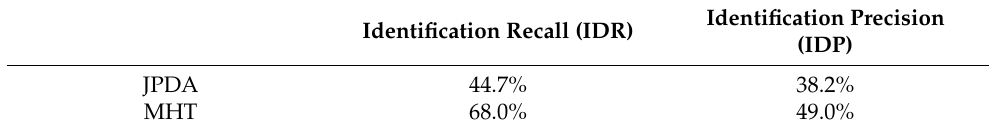
Table 2. Comparison of precision and recall scores from